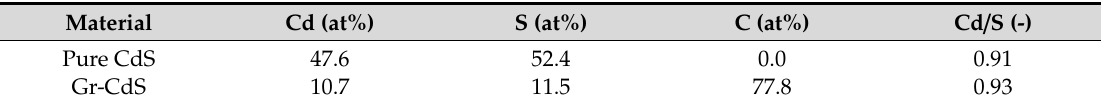
Table 2. Elemental composition of pure CdS and Gr–CdS nanocomposite powders measured by EDS.